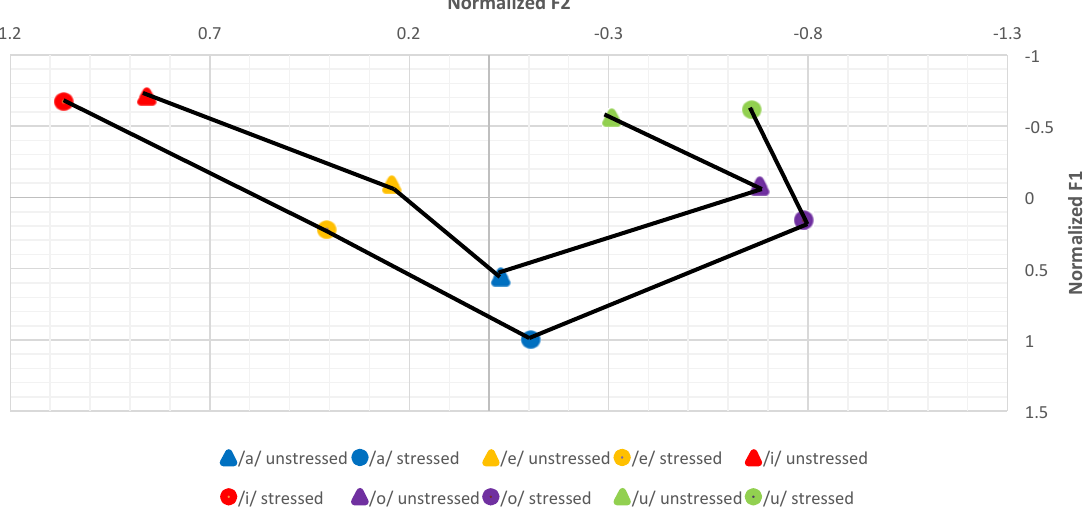
Figure 3. Vocalic triangle of stressed (circles) and unstressed (triangles) vowels based on the averaged normalized F1 and F2 values.